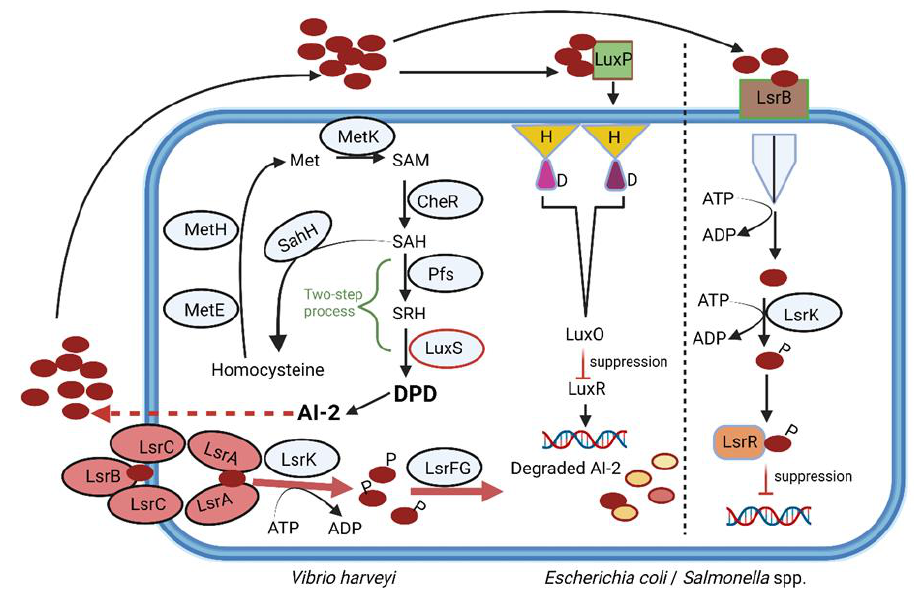
Figure 3. Production of AI-2, regulated by LuxS (an autoinducer synthase). S-adenosylhomocysteine (SAH) is converted to homocysteine by SAH hydrolase (SahH) in a one-step reaction but may also be produced from the cleavage of the thioether linkage of S-ribosylhomocysteine (SRH). This is a two-step reaction that requires SAH nucleosidase (Pfs) and LuxS. The intermediate 4,5 dihydroxy-2,3- pentanedione (DPD) is rearranged to form AI-2. Red circles = AI-2; LsrB-LsrC-LsrA = Lsr ABC-type transporter; LsrK = Lsr kinase; LsrFG = genes F and G, part of the Lsr operon; MetE = cobalamin- independent methionine synthetase; MetH = cobalamin-dependent methionine synthetase; MetK = adenosylmethionine synthetase; CheR = methyltransferase; P = phosphate group; LuxO = a central regulator; LuxR = repressor. This illustration was constructed using BioRender (https://biorender.com/, assessed on 5 September